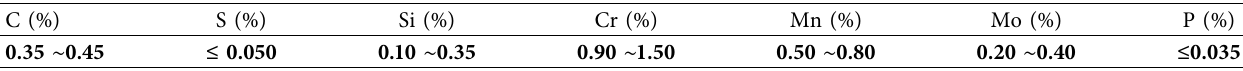
Table 2: Chemical compositions of E19